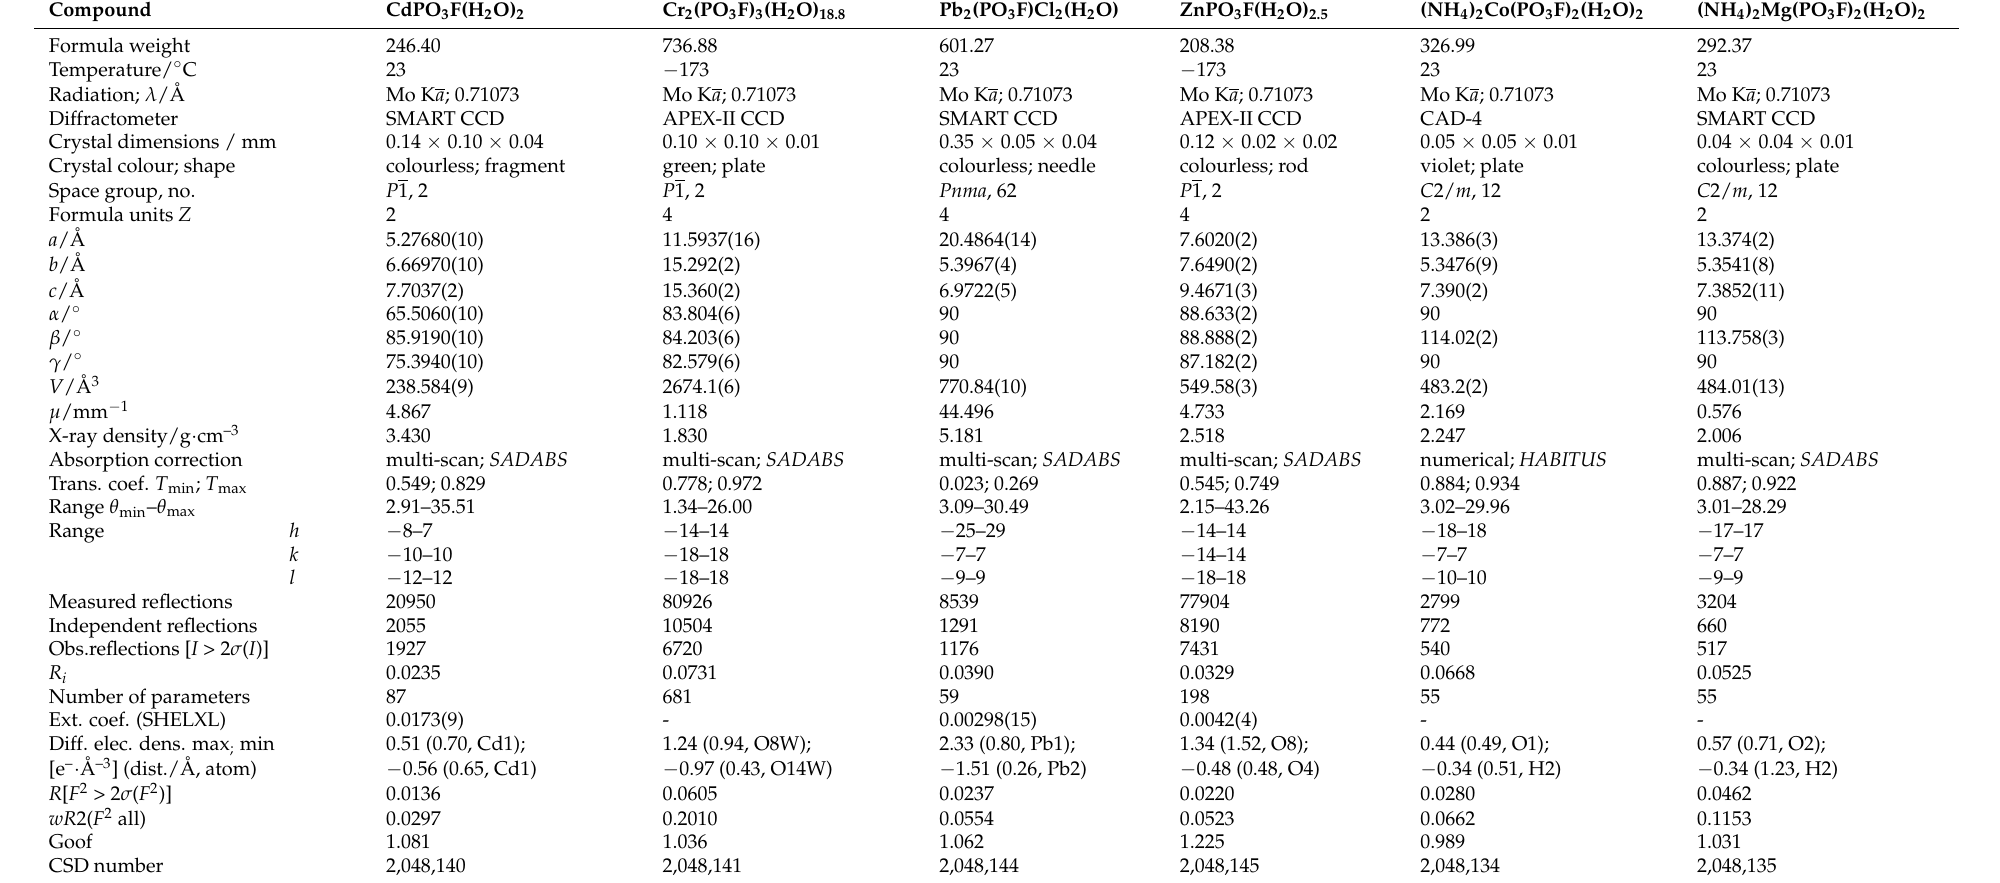
Table 1. Details of data collections and structure